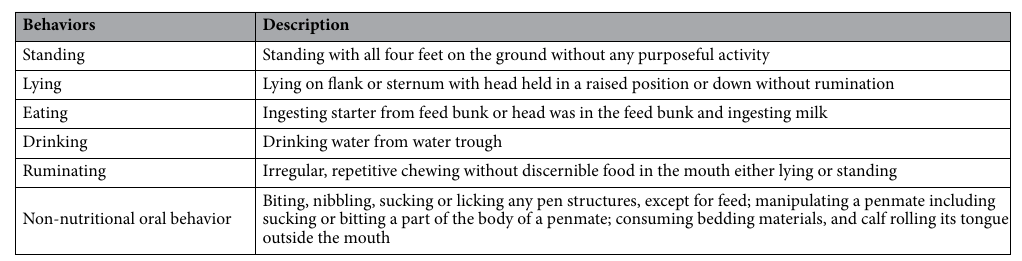
Table 5. Description of the recorded behaviors by Leruste et al. 46 and Abdelfattah et al. 47